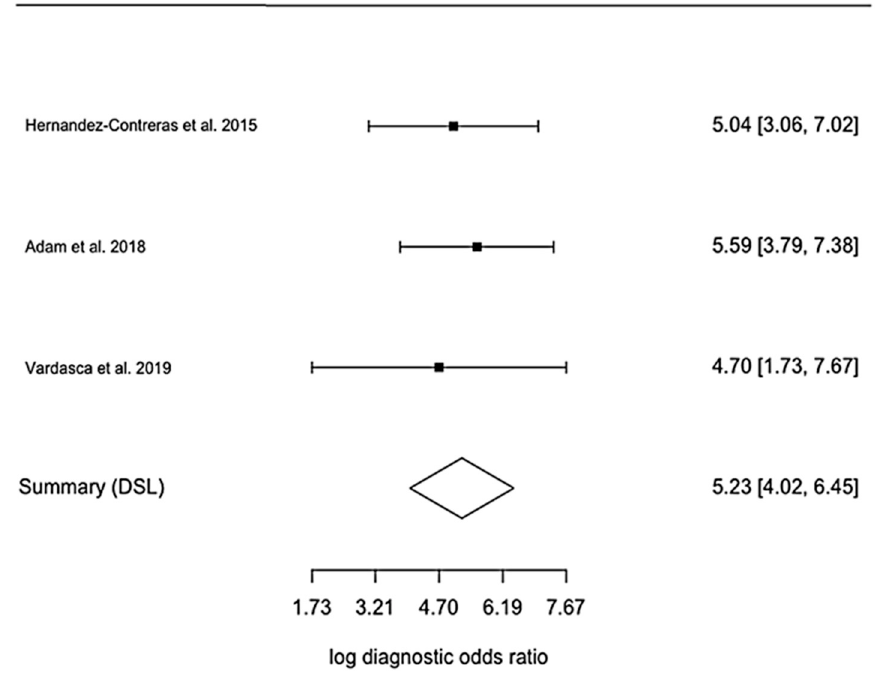
Figure A6. Forest plots for log diagnostic odd ratios for diabetic foot studies.